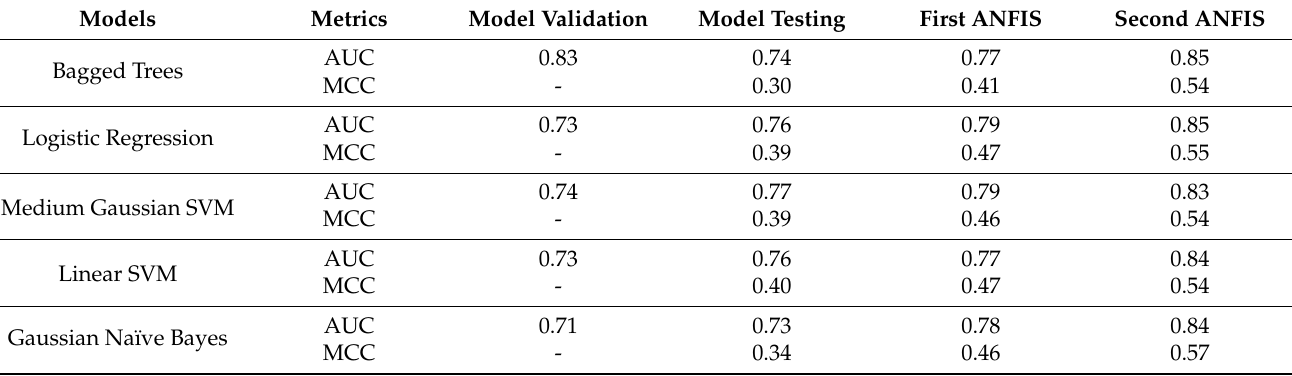
Table 11. Test results for AHI